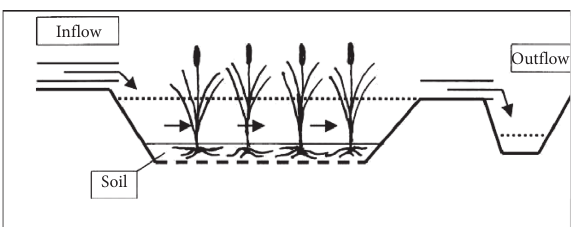
Figure 1: Schematic representation of the free-water surface constructed wetland with emergent macrophytes (source: